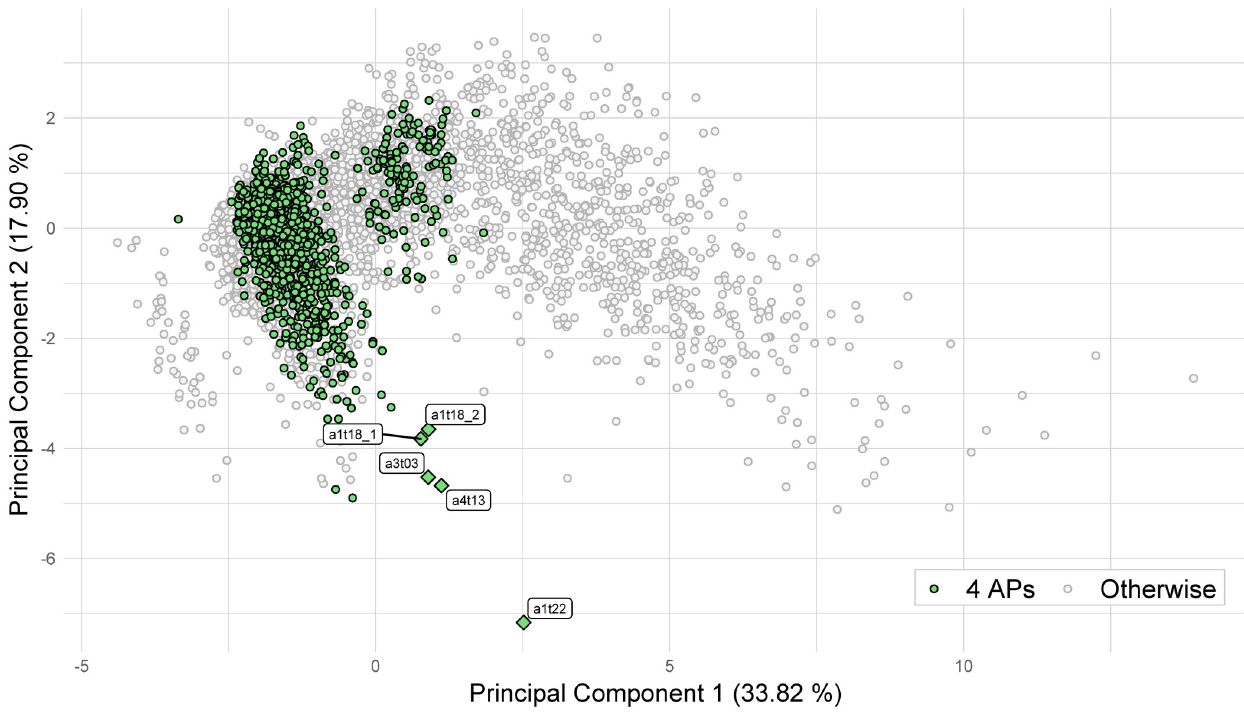
Fig 6. Plot of the first two principal components of τ A + τ B of the HH experiments (circular points), with experiments with 4 APs highlighted, and projections of the SGAMP experiments (rhombus points).